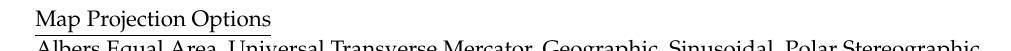
Table 2. Processing options available for scenes ordered within the